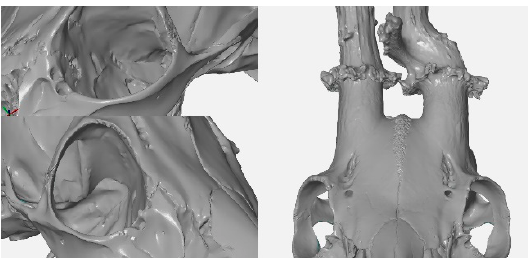
Figure 10. 3D scanner—a detailed view of external structures, including view of the fossa lacrimalis externa , and detail of cranial vault sutures.